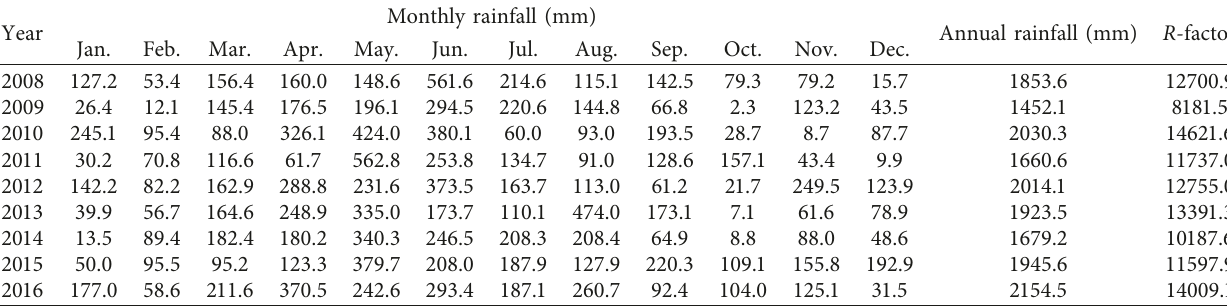
Table 1: Mean monthly rainfall and R -factor in NNNR.